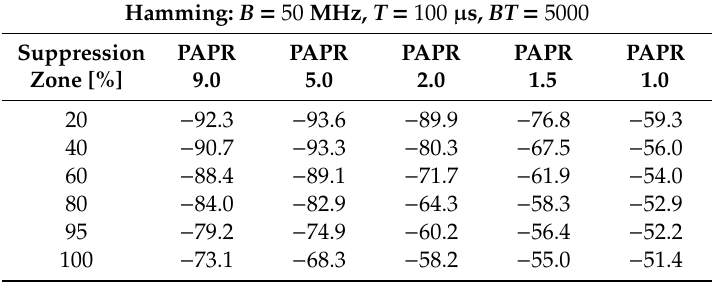
Table 5. Mean PSL (dB) on 100 trials using FMeth varying the PAPR and the percentage of the suppression zone. Noise waveforms with Hamming